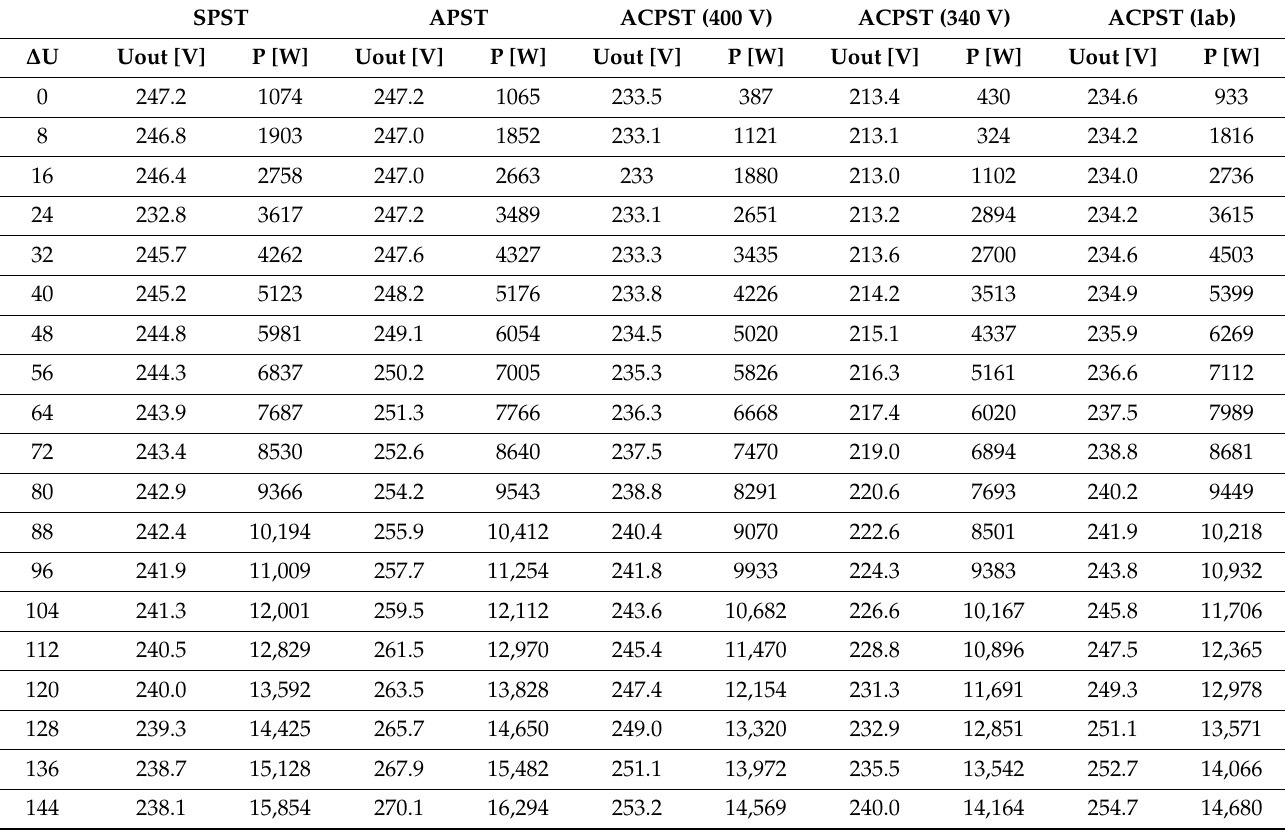
Table 3. Set quadrature voltages, output voltages, and transmitted active powers for different